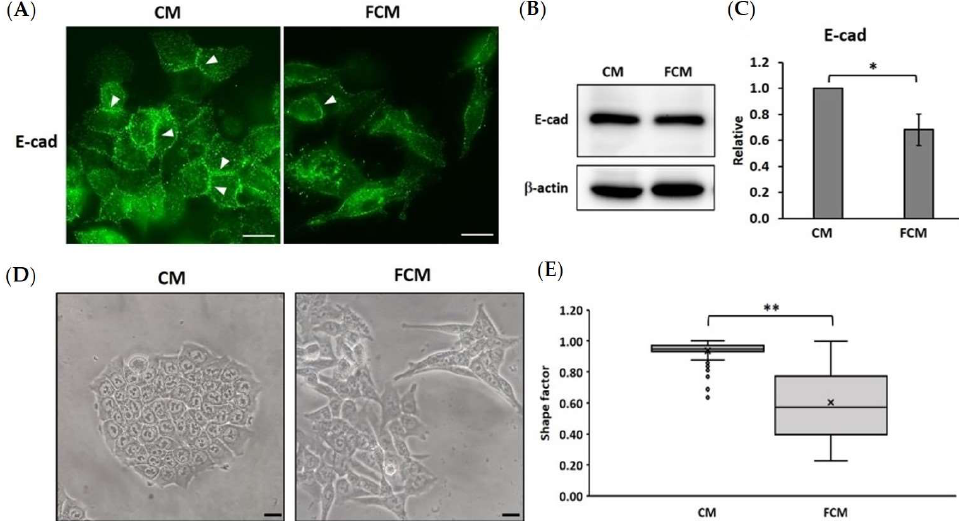
Figure 3. FCM activate EMT process in HCT116 cells. ( A ) Immunofluorescence assay represents a loss of adherent molecule, E-cadherin when treated with FCM. Arrowhead points to the junction between the cancer cells (magnification 400×). ( B ) Western blot analysis represents a decreasing of E-cadherin expression in FCM-treated cell and ( C ) the graph illustrates a relative intensity of E-cadherin protein band with β-actin. ( D ) Cancer cells were treated with FCM for 48 h to investigate the morphology changed under microscope (magnification 400×). ( E ) Morphology appearance was analyzed by shape factor equation. The analyzed data are illustrated with box plot (n = 100). * Represents p ≤ 0.05 and ** represents p ≤ 0.01 compared between groups. CM = complete media (control), FCM = fibroblast-cultured media, E-cad = E-cadherin.